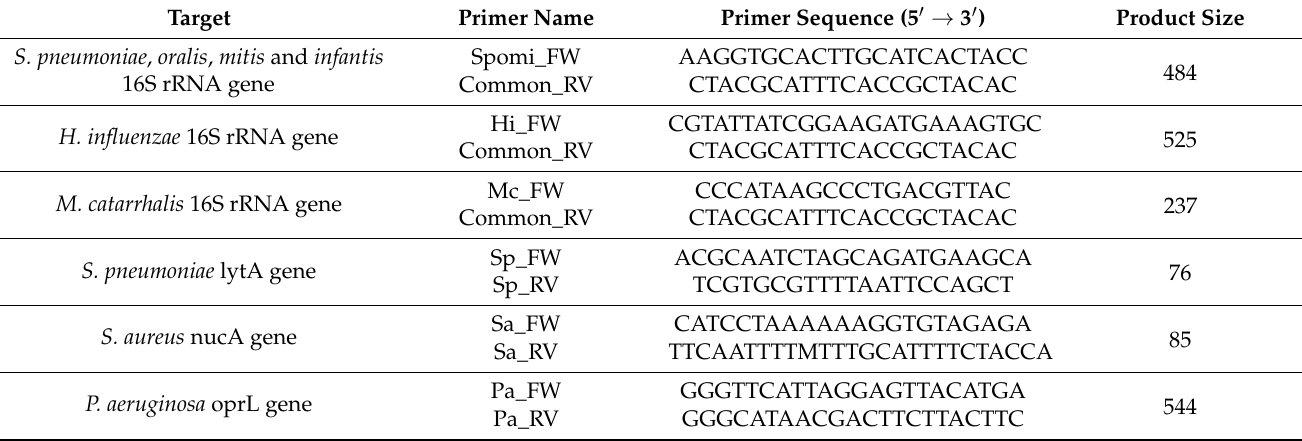
Table 2. List of primers for specific PCR detection of target pathogens.